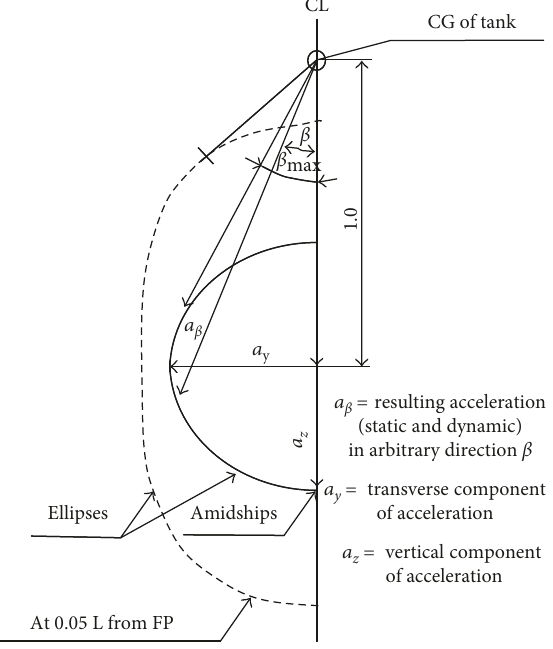
Figure 8: Acceleration ellipsoid